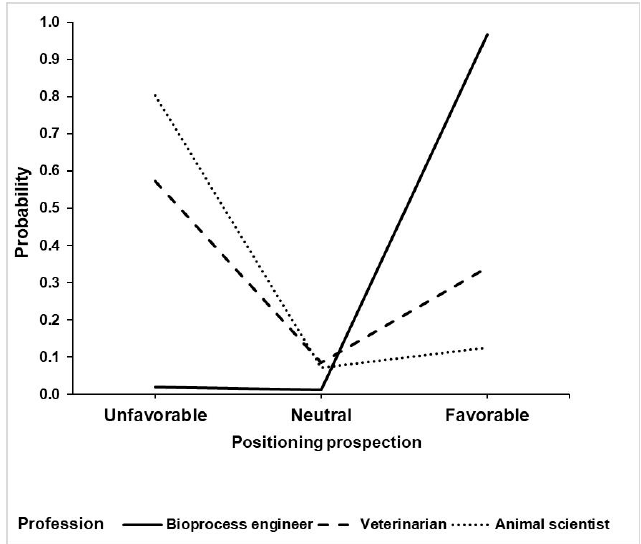
Figure 5. Adjusted logit model for the perception of the probable position that veterinarians, animal scientists and bioprocess engineers will assume regarding the production of cell-based meat, according to an online questionnaire by 209 Brazilian veterinarians and 63 animal scientists. Animals 2020 , 10 , x